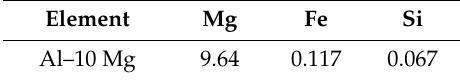
Table 1. The chemical composition (wt %) of Al–10Mg alloy. Element Mg Fe Si Al–10 Mg 9.64 0.117